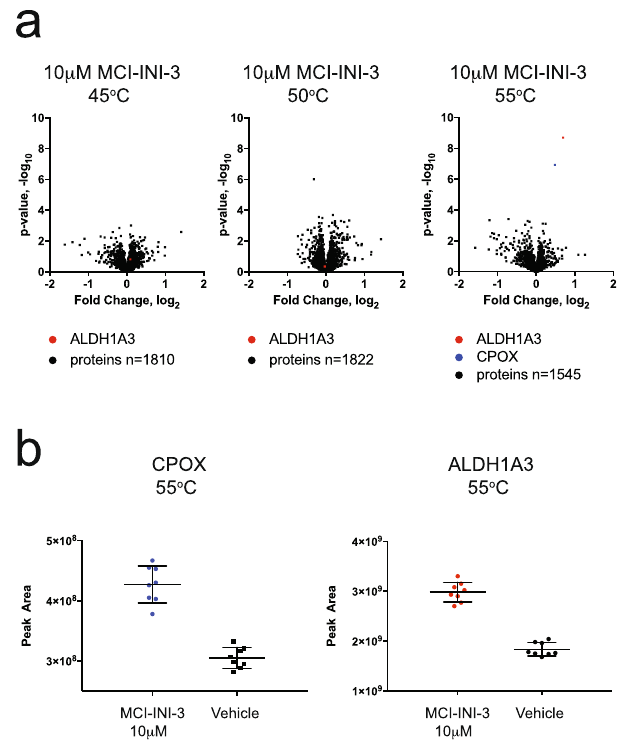
Fig. 8 Selective binding of MCI-INI-3 to ALDH1A3 in glioma stem cell lysates. a Scatter plots of statistical signi fi cance versus the change in relative protein abundance for 1810, 1822, and 1545 protein groups were determined by label-free differential mass spectrometry for cellular thermal stability experiments conducted at 45, 50, and 55 °C, respectively. Quanti fi cation of unique protein groups was accomplished with the MaxQuant software program and outliers were removed with peptide occupancy fi ltering. b Box and whisker plots of ALDH1A3 and CPOX protein abundance for vehicle and MCI-INI-3 treated (10 μ M) lysates following heating at 55 °C and centrifugation at 25,000 × g . Each of the eight technical replicates ( n = 8) was digested with trypsin and subjected to LC- MS/MS based proteomic